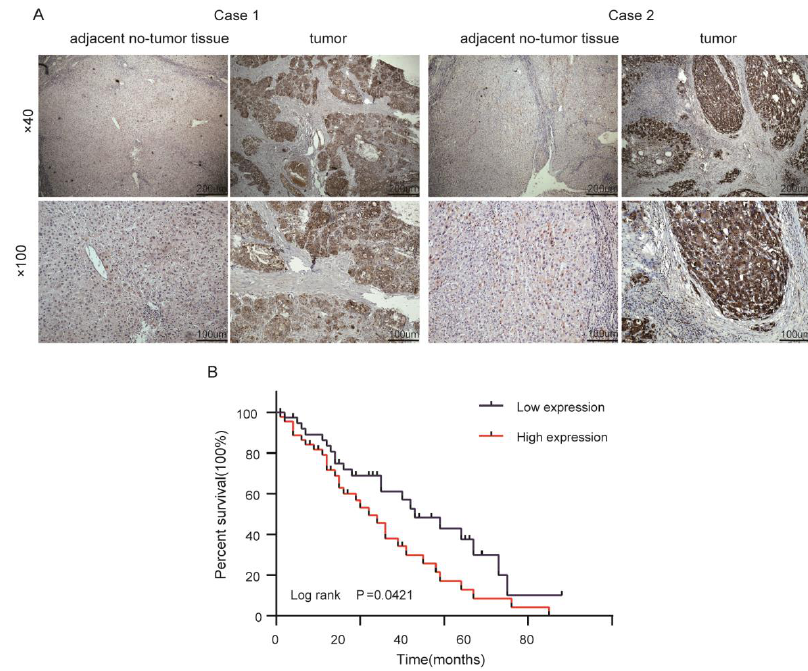
Figure 9. High expression of RPS24 and poor prognosis in HCC. ( A ) Immunohistochemical staining of RPS24 levels was performed using 86 pairs of cancer tissue and adjacent non-tumor tissue, and representative images are shown. ( B ) The survival analysis was performed on different RPS24 groups using cohort